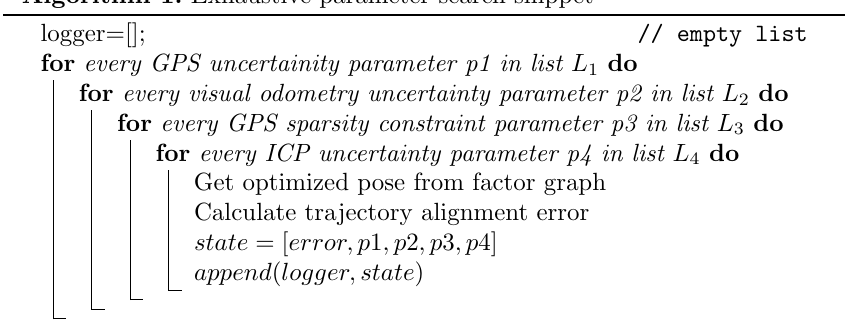
Algorithm 1: Exhaustive parameter search snippet